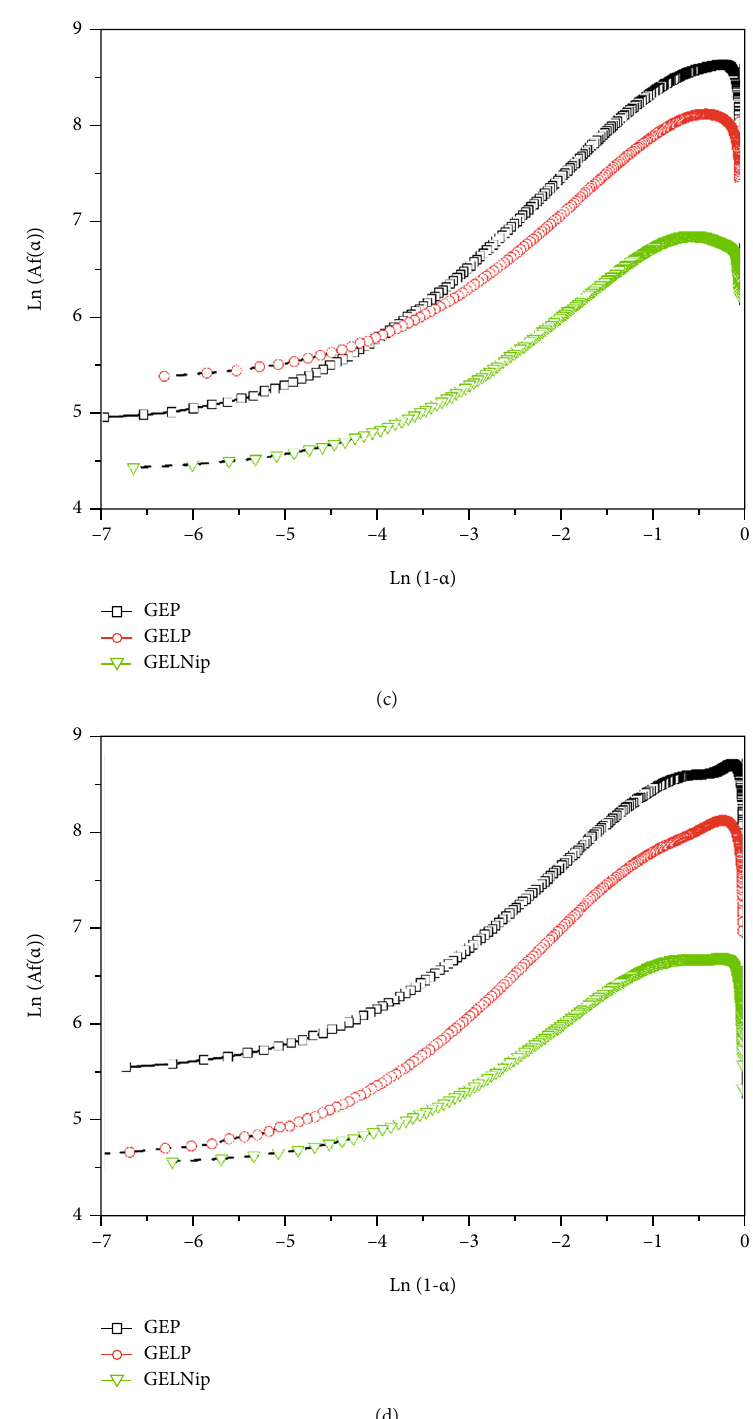
Figure 10: Typical plots of ln [Af( α )] vs. ln (1- α ) for the samples under heating rate of 5 ° C.min − 1 used in calculation of activation energy via Friedman